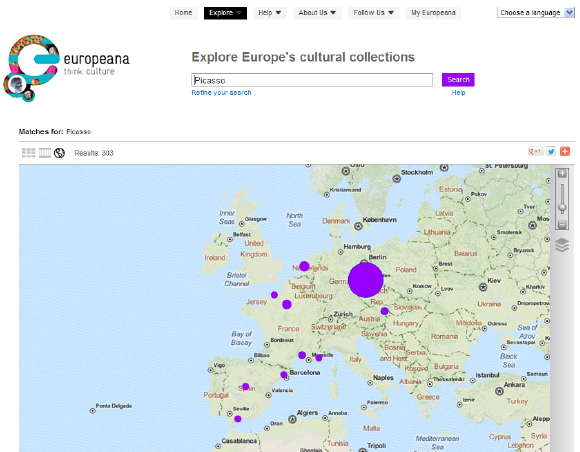
Figure 2. Europeana is able to manage geographic position and time in its